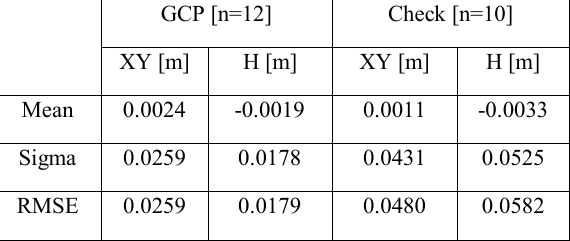
Table 1. The accuracies of image georeferences in the aerial triangulation process (overlap 80/60)